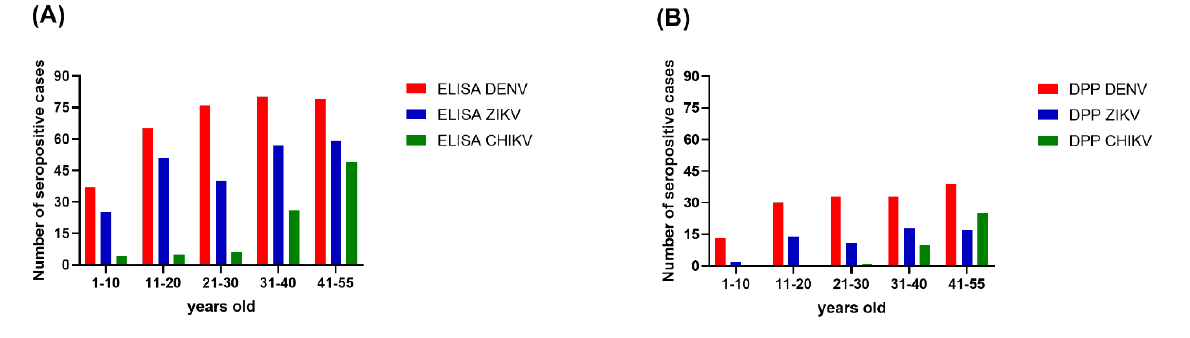
Figure 2. Seroprevalence of three arboviruses by age group. ( A ) The ELISA results; ( B ) The DPP ® ZCD IgG results. The x-axes describe the DENV (red), ZIKV (blue), and CHIKV (green) distributions for five age groups in Bangphae district, Ratchaburi province, Thailand. The y-axes represent the seroprevalence, as shown by the number of cases.